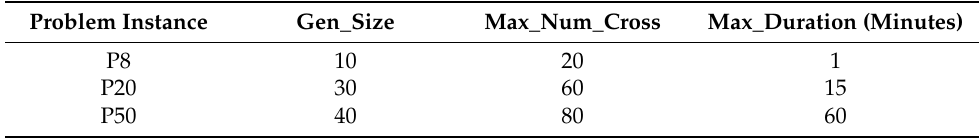
Table 3. GA heuristic parameter setting.